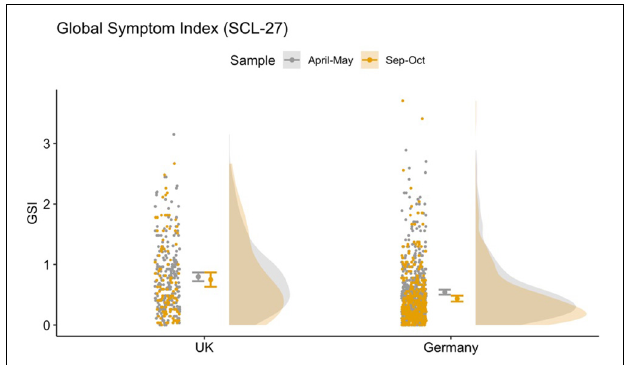
FIGURE 3 | Raincloud plot for total SPQ across country and sample, showing data distribution (the “cloud”), jittered raw data (the “rain”), mean and standard